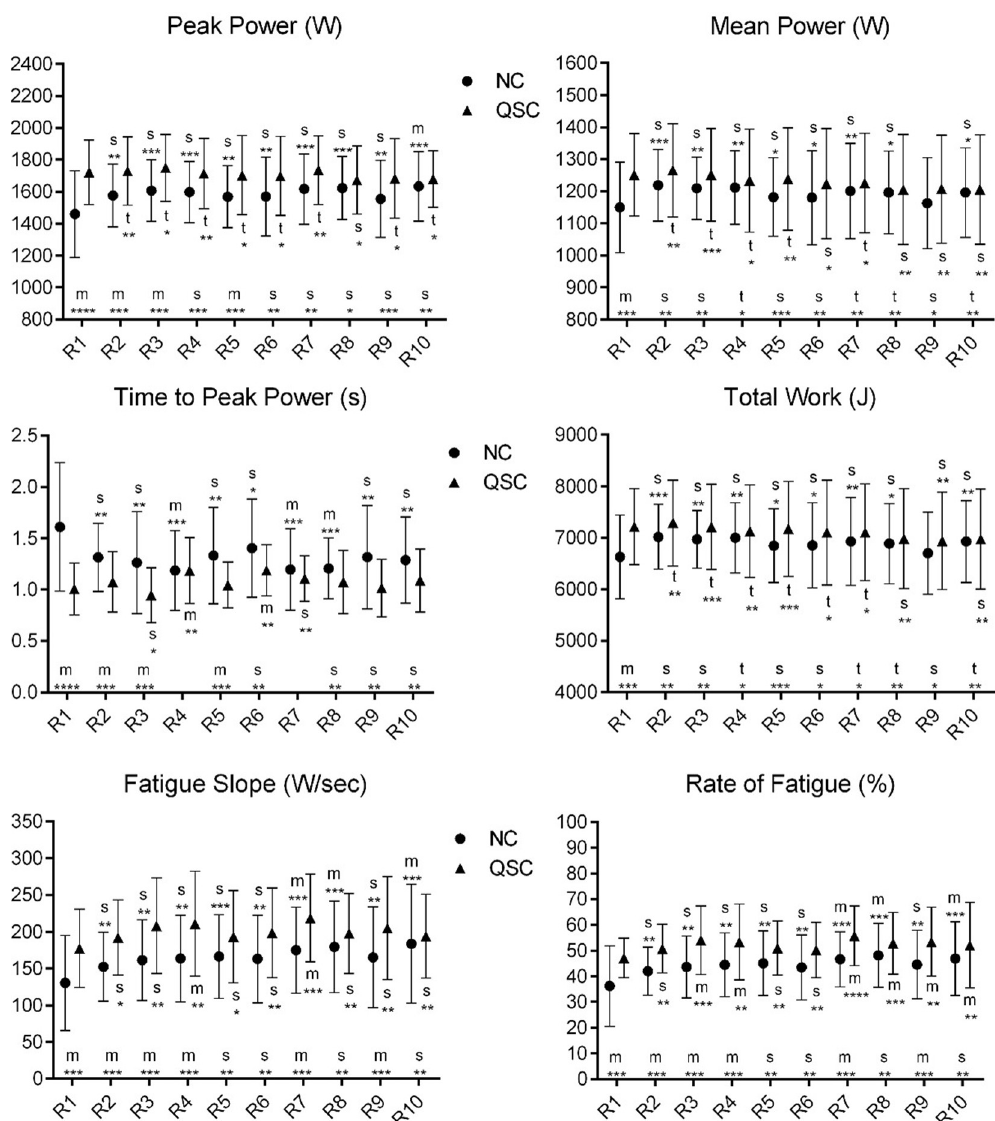
Fig 1. Change in the means of power-related variables in each repetition in NC and QSC. Error bars are 90% compatibility intervals. Letters stand for the magnitude of the mean change values as following: t = trivial; s = small; m = moderate. Asterisks indicate the likelihood for the magnitude of the true effect as follows: � possible; �� likely; ��� very likely; ���� most likely. Letters and asterisks next to the x-axis indicate the magnitude and uncertainty of the mean changes from the NC to QSC. Letters and asterisks above and below the error bars indicate the magnitude and uncertainty of the mean changes from the 1st repetition to the 2nd to 10th repetition in NC and QSC. Effects are unclear in the situations without letters or